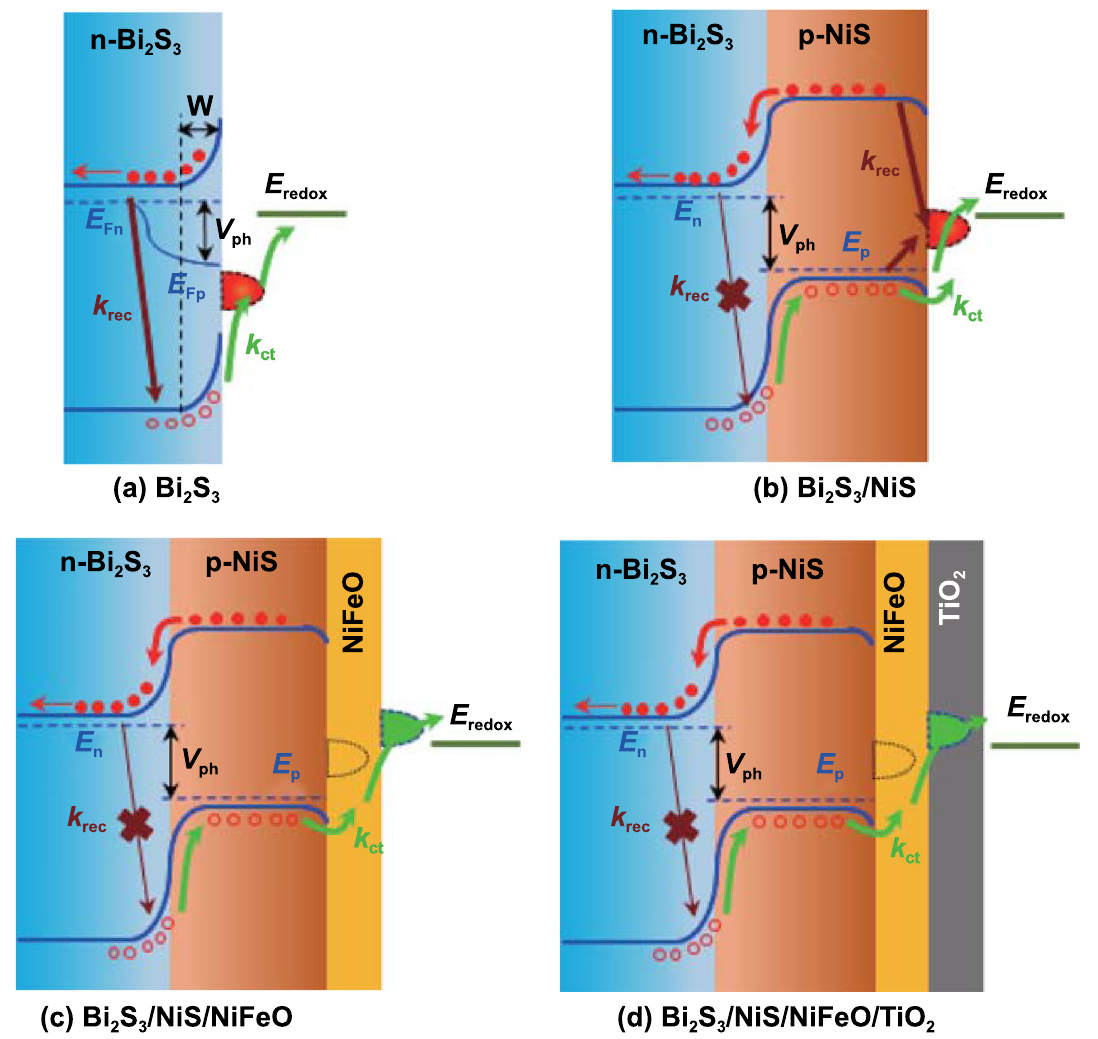
Fig. 5 Band alignment of a bare Bi 2 S 3 , b Bi 2 S 3 /NiS, c Bi 2 S 3 /NiS/NiFeO, and d Bi 2 S 3 /NiS/NiFeO/TiO 2 under forward bias. At equilibrium, the Fermi levels are aligned by electron sharing, which forms the internal field. Electrons and holes are spatially separated, and the maximum V ph